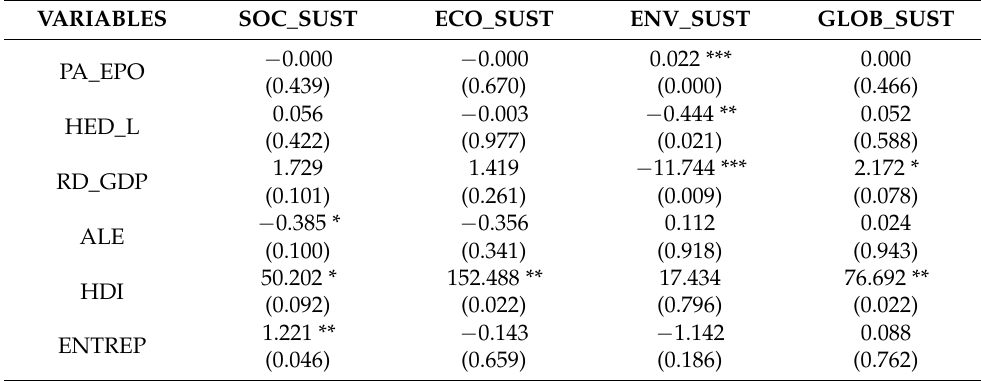
Table 6. Econometric estimations—marginal effects after panel data